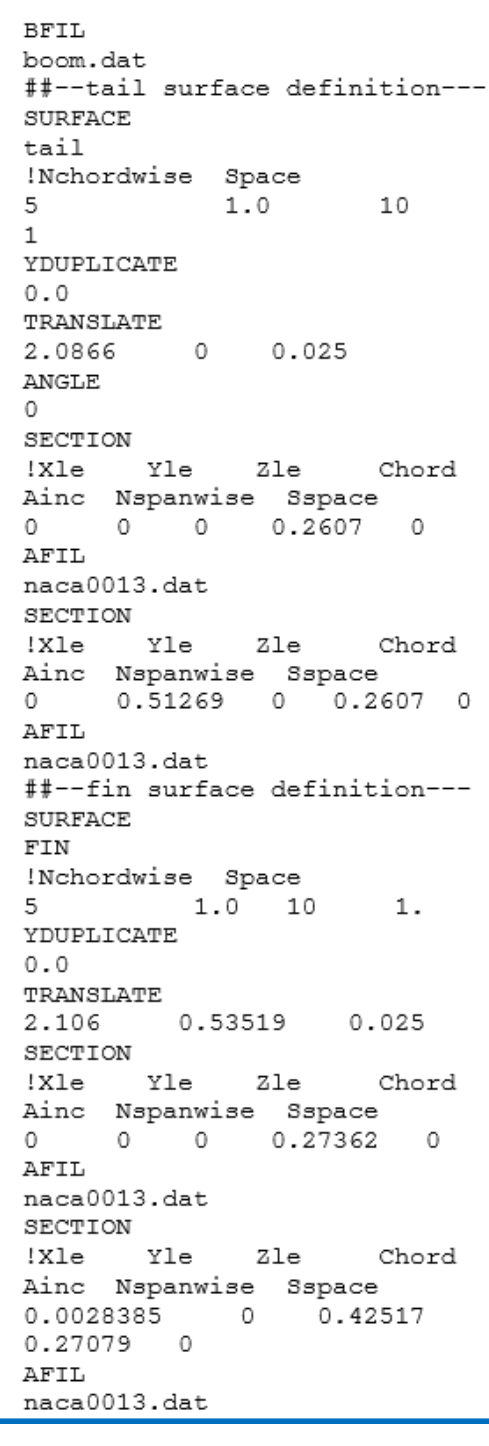
Figure A1. An explanatory geometry input file. It is a compulsory file to perform analysis in Athena Vortex Lattice (AVL). Here, it describes the Aegis UAV configuration obtained using interactive optimisation for 3000 evaluations.